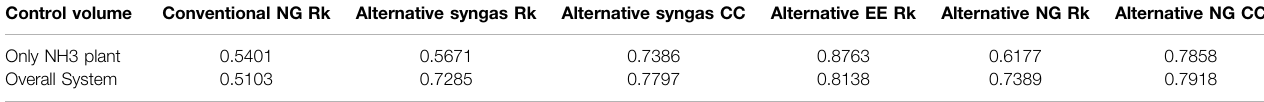
TABLE 3 | Renewability index of the conventional and the alternative scenarios.